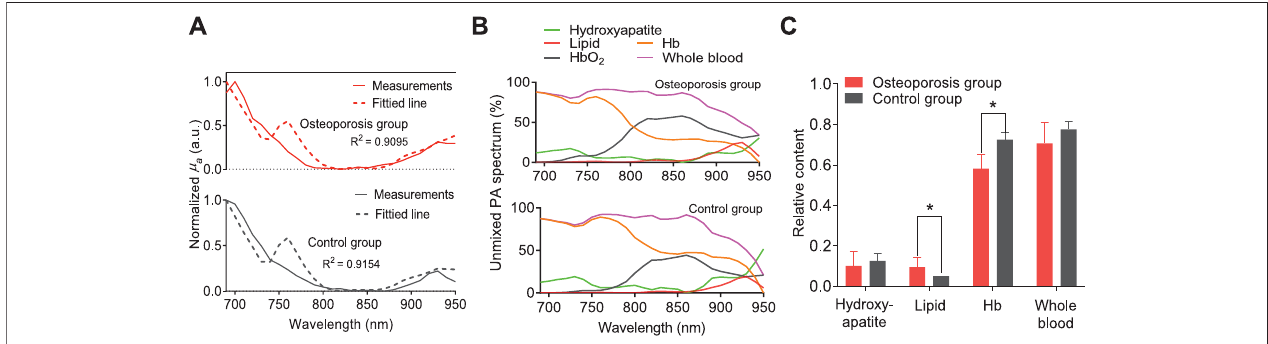
FIGURE 5 | (A) The averaged PA spectrum in comparison with the fi tted spectrum by using the least-square method. (B) The unmixed spectrum of the MWPA curves for the sample from osteoporosis group and control group, respectively. (C) The relative contents of the hydroxyapatite, lipids, deoxygenated hemoglobin (Hb), and whole blood (Hb+HbO 2 ). * stands for p <